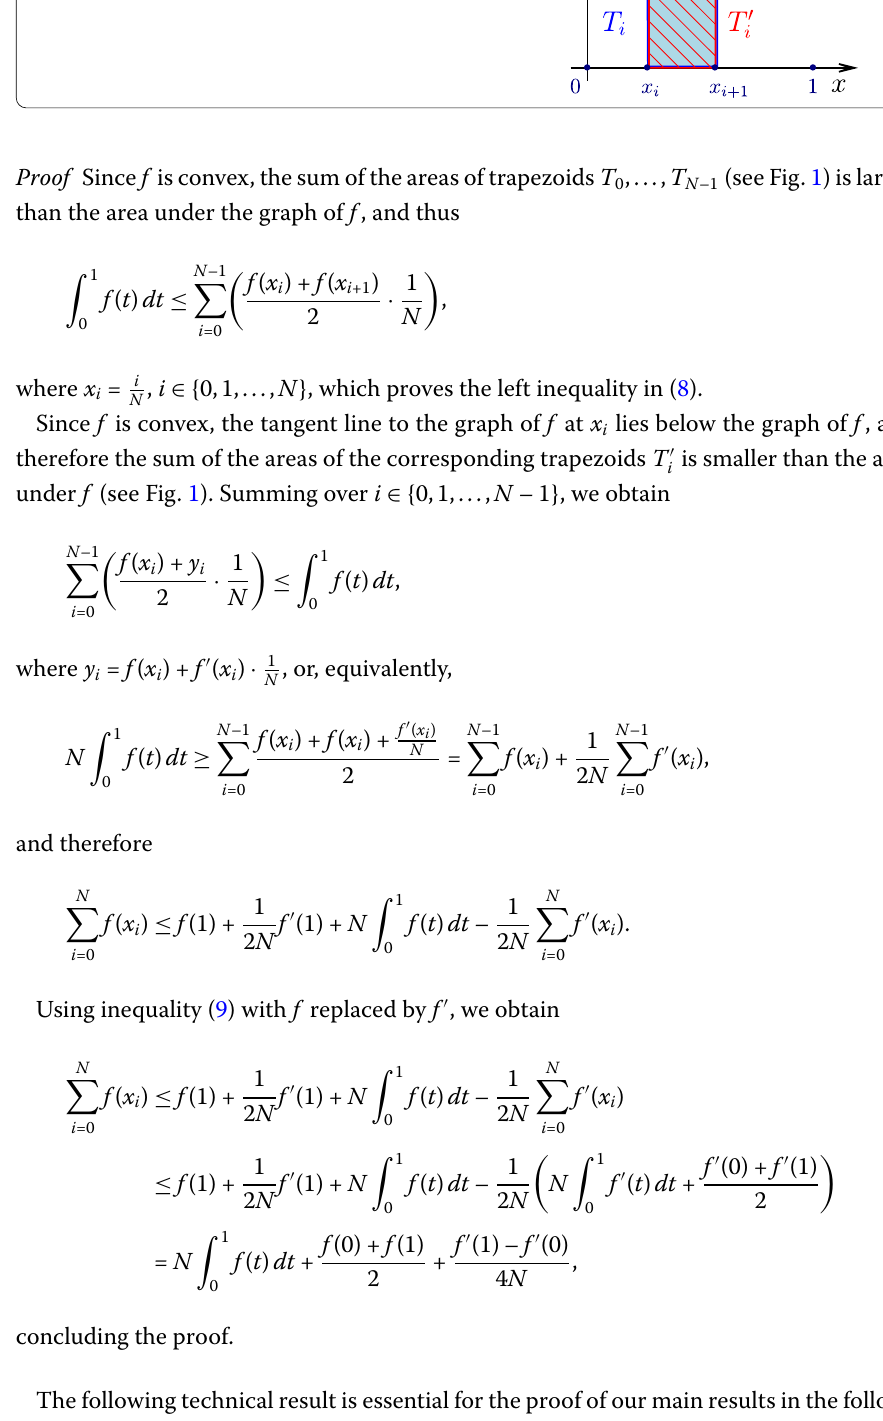
Figure 1 Trapezoids T i and T (cid:7) (cid:12) xi ≤